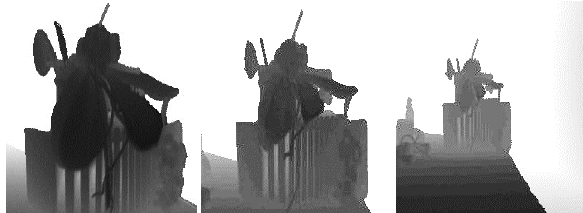
Figure 6: Range images for object distances of approximately 25 cm, 50 cm and 1 m (from left to right). Smaller distances are encoded with darker pixel values, whereas larger distances are encoded with brighter pixel values.